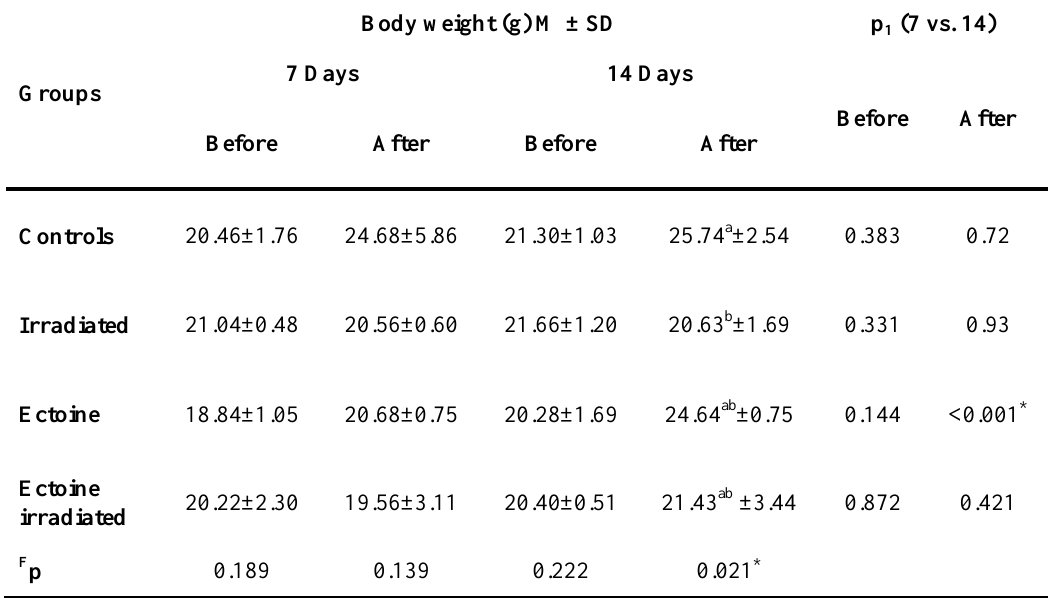
Table 1. Body weights of the studied groups before and after treatments